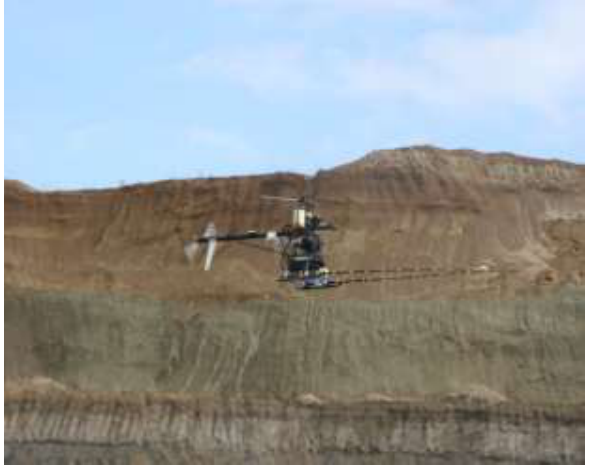
Figure : Gasoline engine driven UAS (Scout B1 aeroscout gmbh, Switzerland) operating in an open pit coal field, Turkey. The magnetometer is mounted on a stinger in front of the